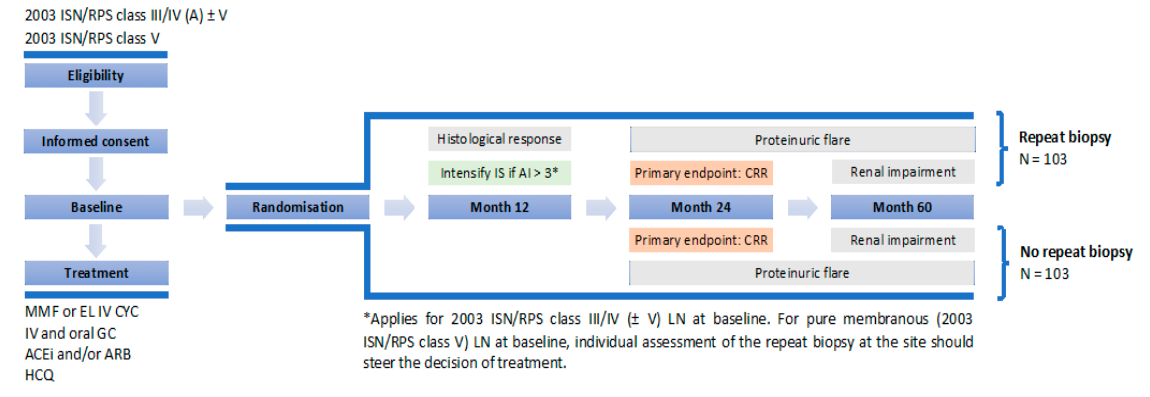
Figure 1. REBIOLUP flowchart.